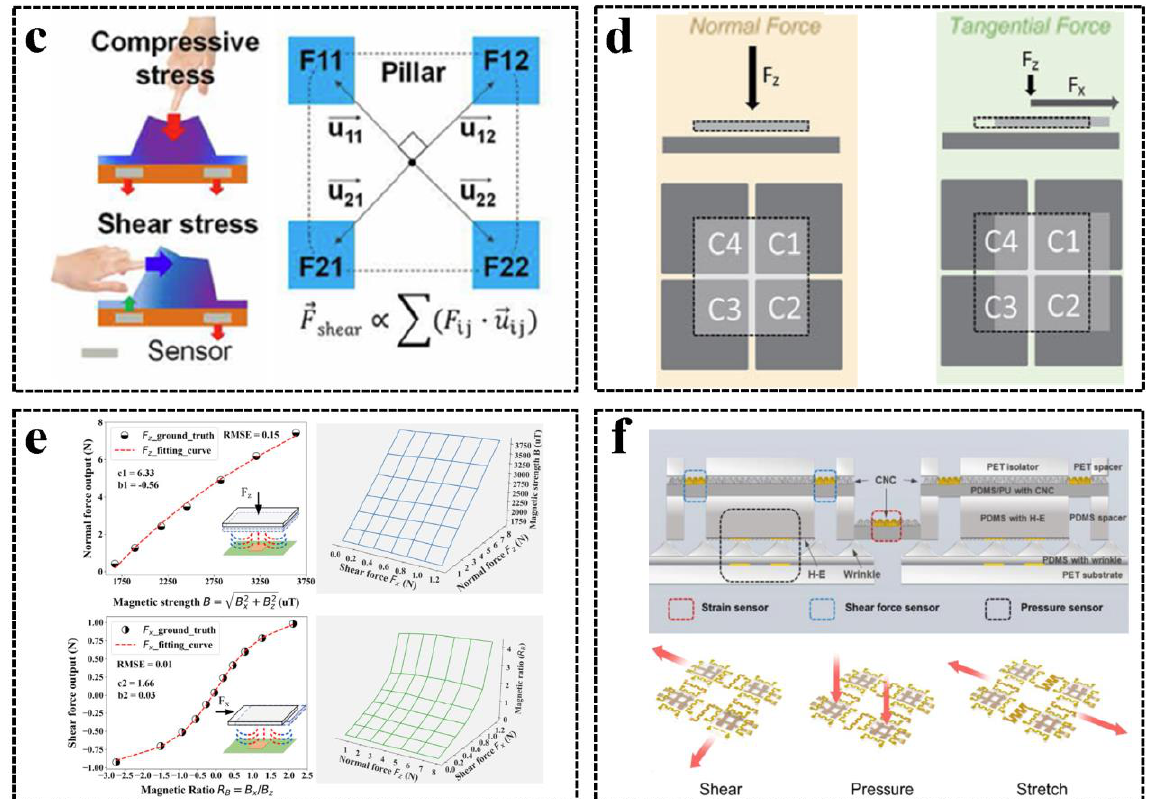
Figure 4. Multi–dimensional tactile sensors: ( a ) Tactile sensors with a single channel. Reproduced with permission [98], Copyright 2018, Wiley–VCH. ( b ) A tactile sensor with two strain sensing units perpendicular to each other. Reproduced with permission [102], Copyright 2019, Wiley–VCH. ( c ) A tactile sensor adds a bump structure for three-dimensional force sensing. Reproduced with permission [112], Copyright 2020, American Association for the Advancement of Science. ( d ) A tactile sensor where four lower electrodes share a common upper electrode. Reproduced with permission [115], Copyright 2014, Wiley–VCH. ( e ) A magnetic multi–dimensional tactile sensor with self-decoupling. Reproduced with permission [72], Copyright 2021, American Association for the Advancement of Science. ( f ) Resistive and capacitive multi–dimensional tactile sensors with the self-decoupling of pressure, shear force, and strain sensing. Reproduced with permission [119], Copyright 2021, Elsevier